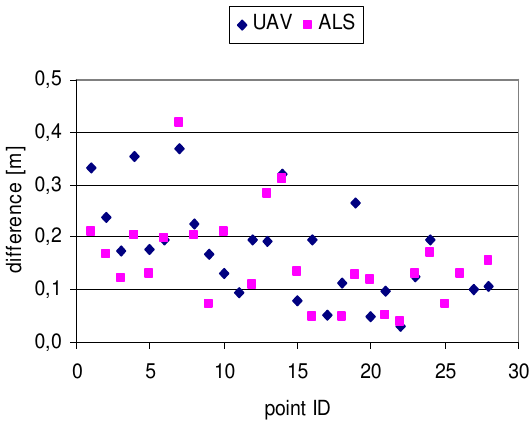
Fig 3.3: Planar differences between Check Points located on 3D models and measured by tacheometer (absolute values).